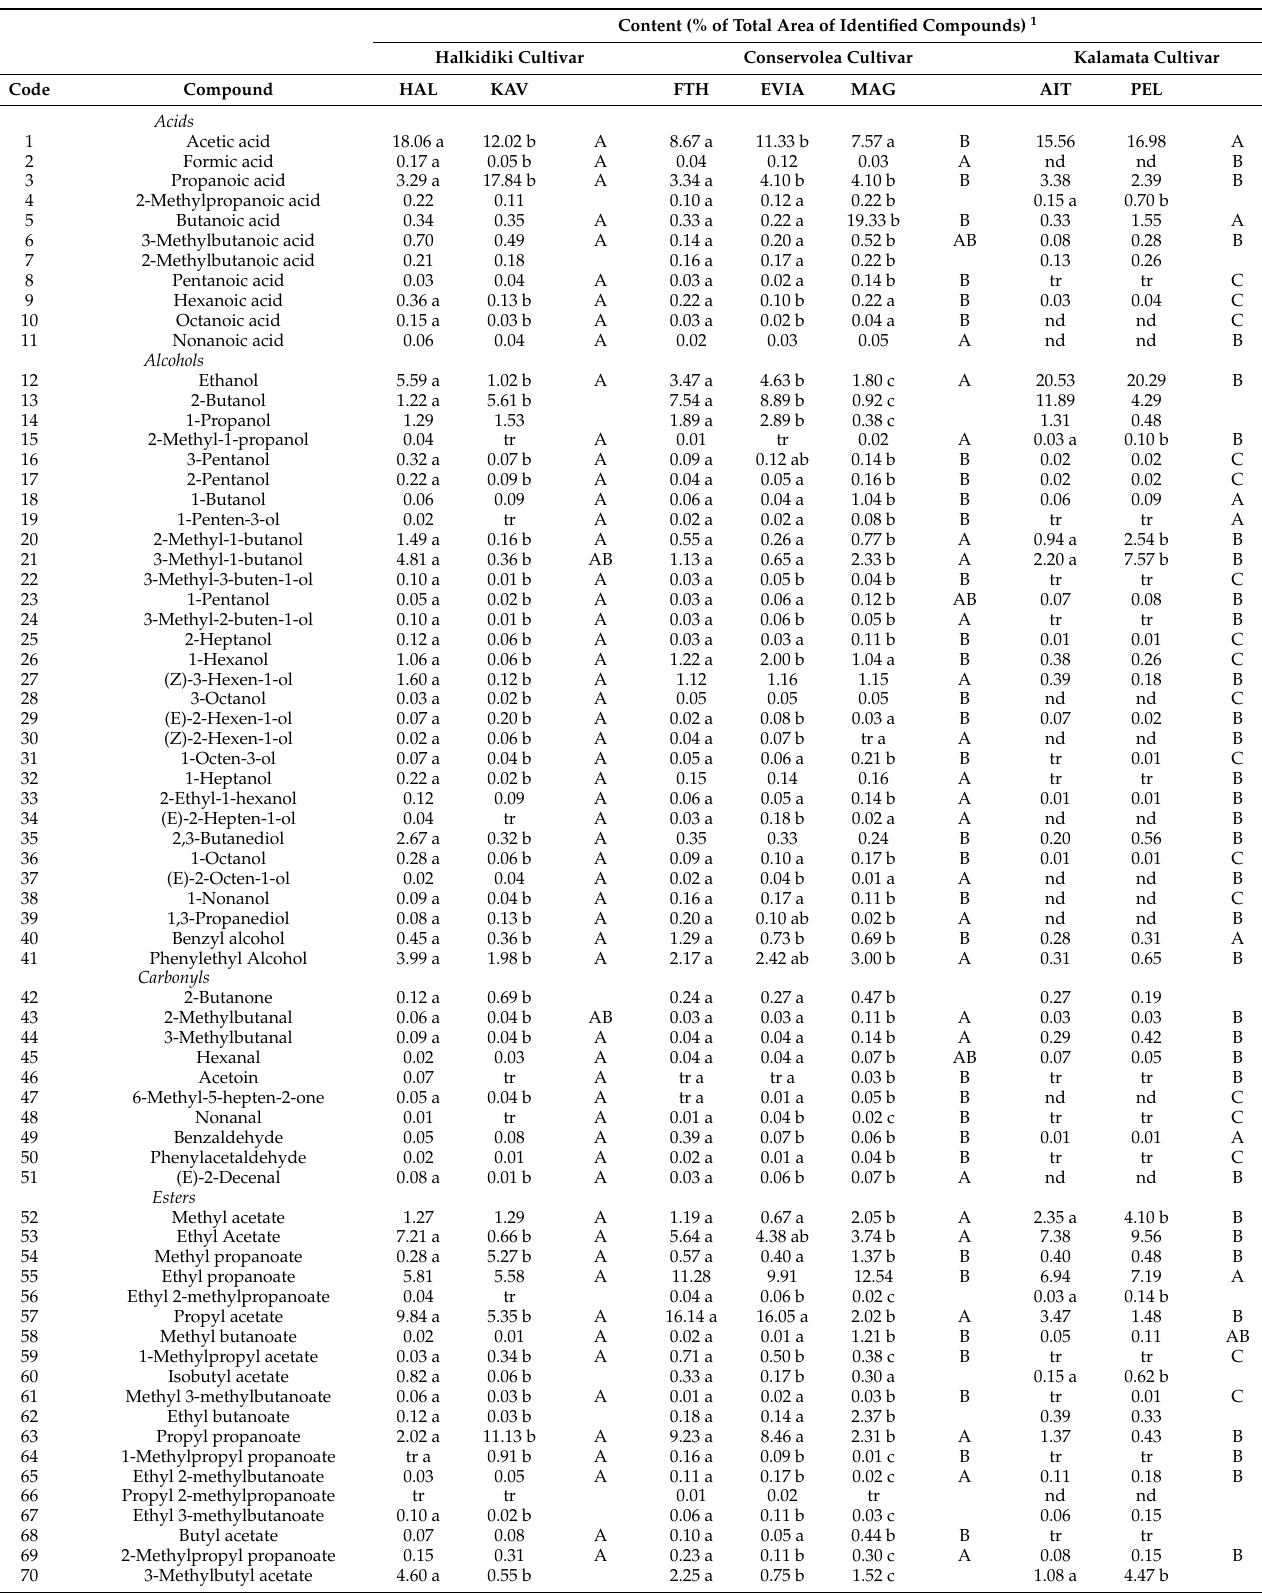
Table 2. Volatile composition of Halkidiki, Conservolea and Kalamata table olives as affected by growing